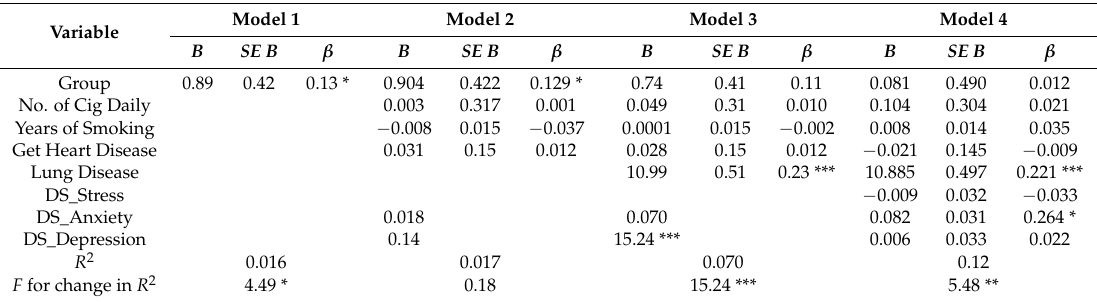
Table 5. Regressing Depression, Anxiety, and Stress Symptoms, Group, and General Perception of Getting Heart Disease onto Respiratory